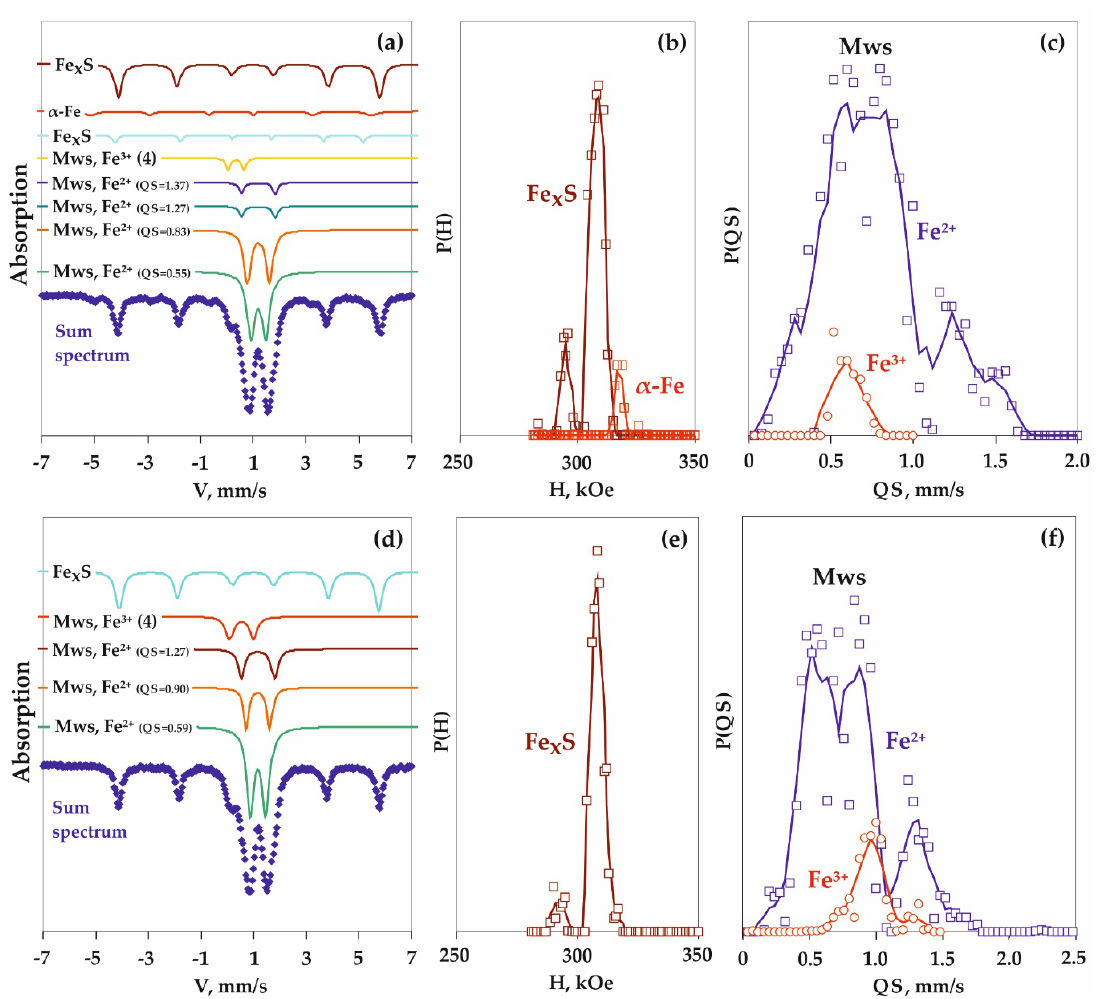
Figure 15. Mössbauer spectra of samples produced in the carbonate-iron system (exp. 1618 ( a – c ) and 1602 ( d – f )) as well as components of these spectra ( a,d ), the probability distribution of hyperfine magnetic fields (H) on iron nuclei ( b,e ) and the probability distribution of quadrupole splittings P(QS) in experimental spectra of magnesiowüstite and silicates ( c,f ).